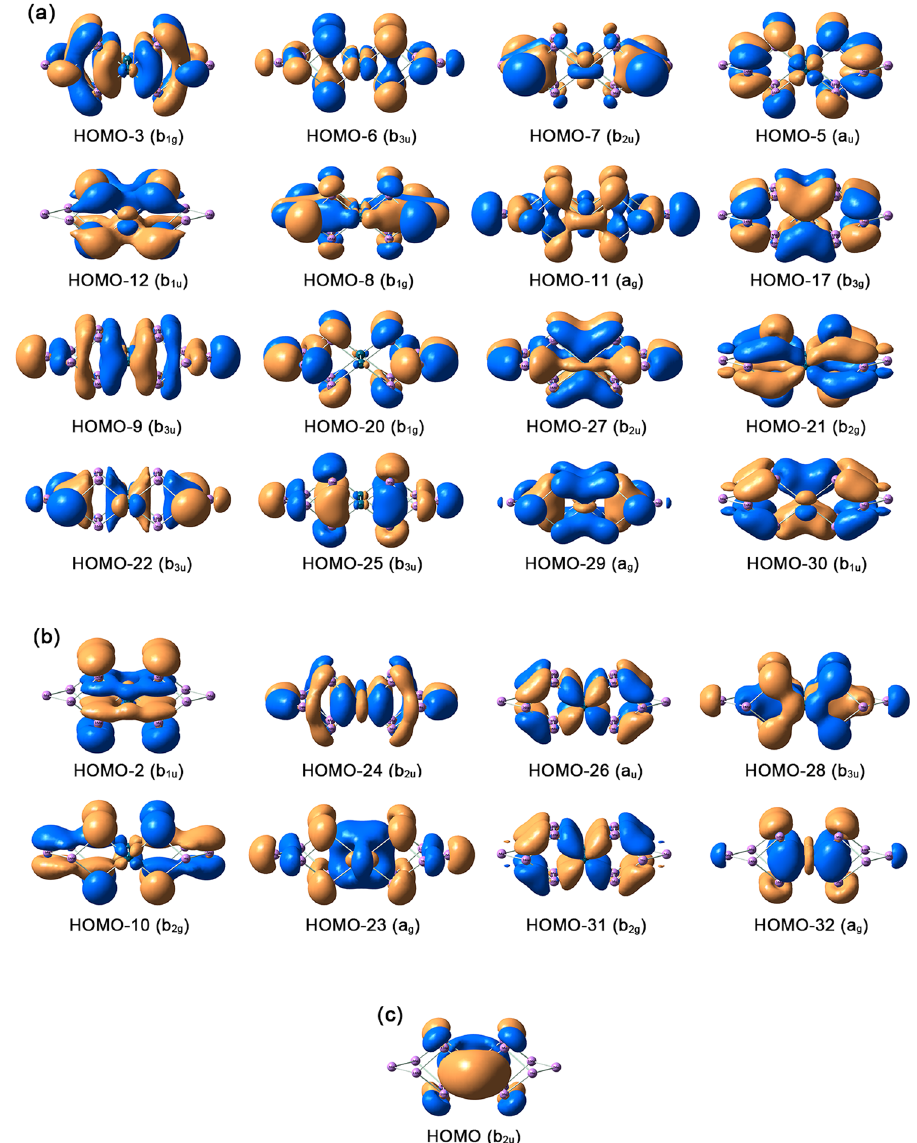
Figure 2. Pictures of selected canonical molecular orbitals (CMOs) in [Pd 2 As 14 ] 4 − ( 1 ), calculated at the PBE0/ def2-TZVP level. ( a ) CMOs for 16 two-center two-electron (2c-2e) As-As σ bonds. ( b ) CMOs for eight 2c-2e Pd-As σ bonds. ( c ) CMO for the globally delocalized σ bond. Additional CMOs are 6 pairs of nonbonding Pd 4d electrons (including four lone-pairs), fourteen As 4s lone-pairs, and two As 4p lone-pairs; see Fig. S5 in the Supplementary